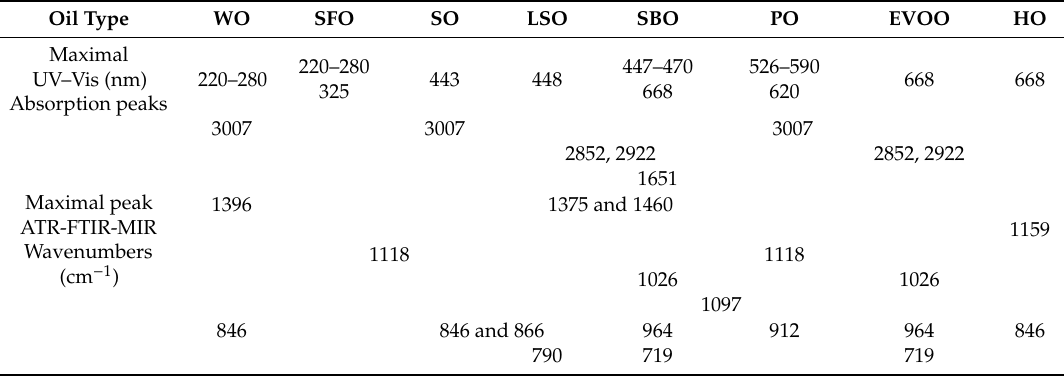
Table 4. Criteria of recognition for eight types of functional oils, based on their botanical origin: maximal absorption peaks in the UV–Vis spectra and the ATR-FTIR-MIR wave numbers. For abbreviations, see Table